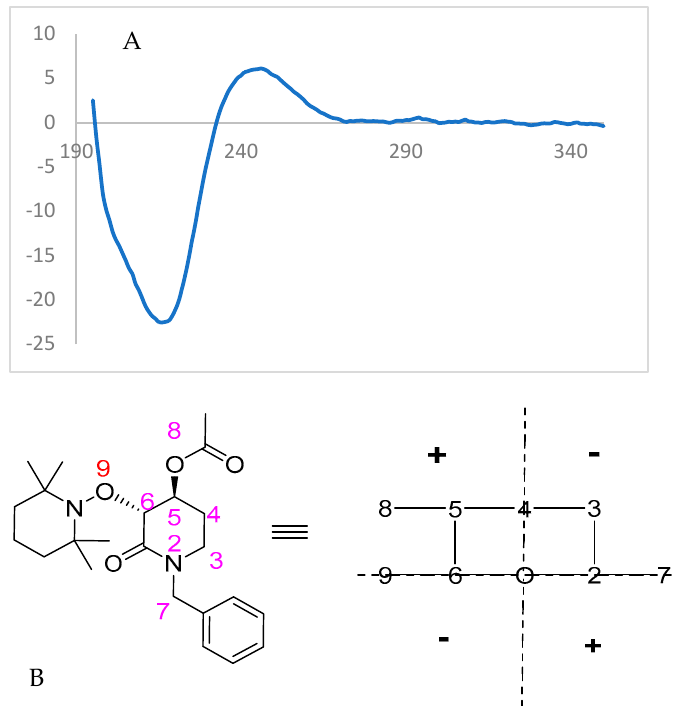
Figure 8. ( A ) Experimental CD spectrum of (3 R ,4 S )-( − )- 3 . ( B ) Structured transformed with octant rule; a positive cotton effect is expected.